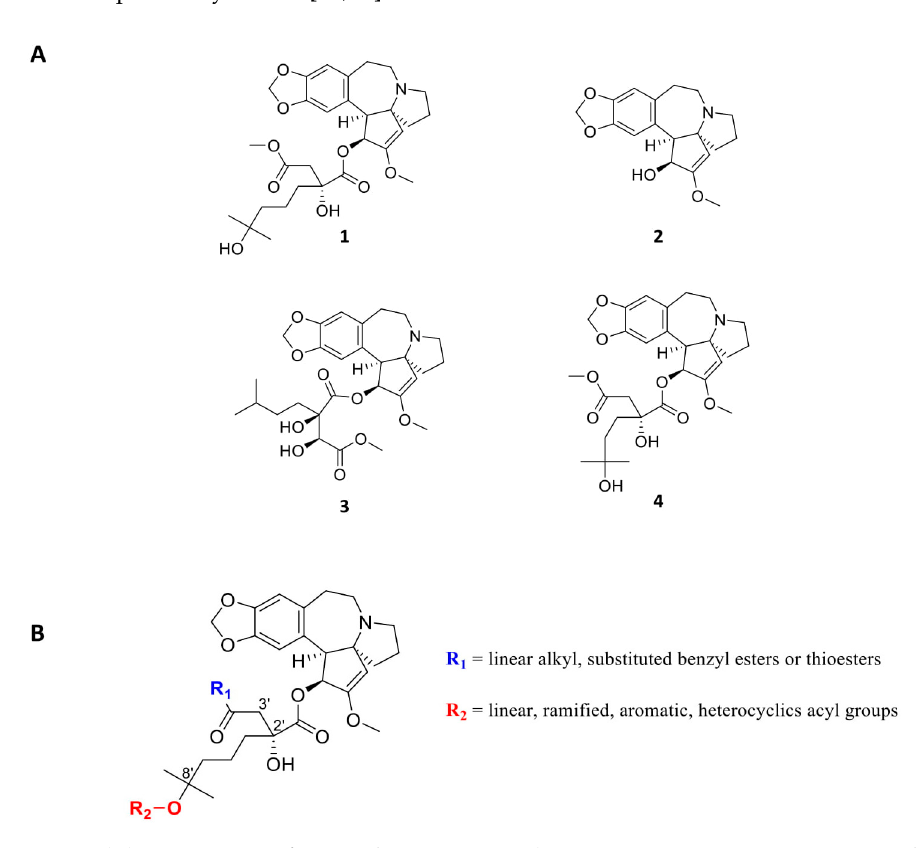
Figure 4. ( A ) Structures of Homoharringtonine (omacetaxine mepesuccinate, Synribo ® ) 1 , Cephalotaxine 2 , Isoharringtonine 3 and Harringtonine 4 . ( B ) Chemical modifications of